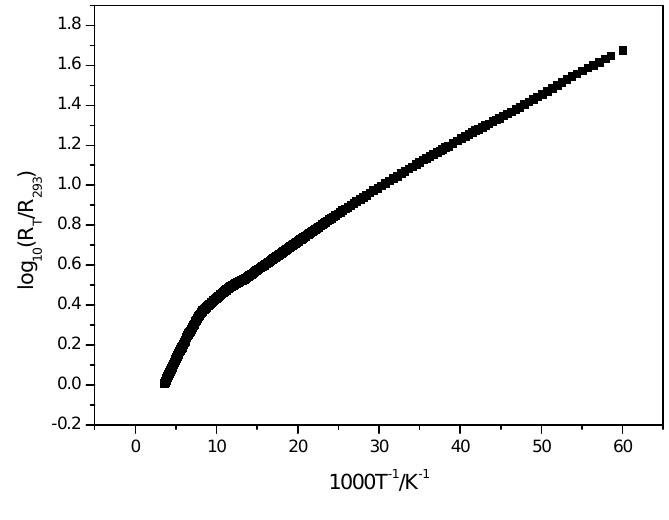
Figure 12. Temperature dependence of resistance for a single crystal of (BMDT- [8,8'-Br (OH) -3,3'-Co(1,2-C TTF) 4 1.16 0.72